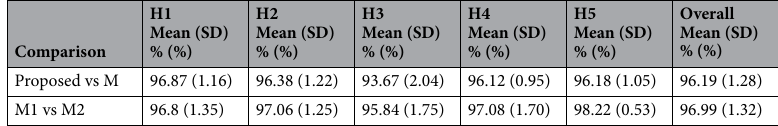
Table 2. Evaluation of automated COB detection; Notation: M1 manual segmentation-1, M2 manual segmentation-2, M average of M1 and M2, SD standard deviation, H-1 to H-5 represents datasets 1 to 5 (100 B-scans per